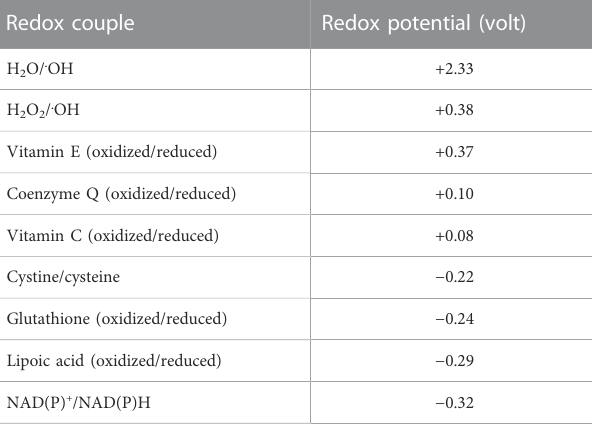
TABLE 5 Redox potentials of redox couples that take part in the detoxi fi cation chain from radical formation in the lipid phase towards the water phase. Redox couple